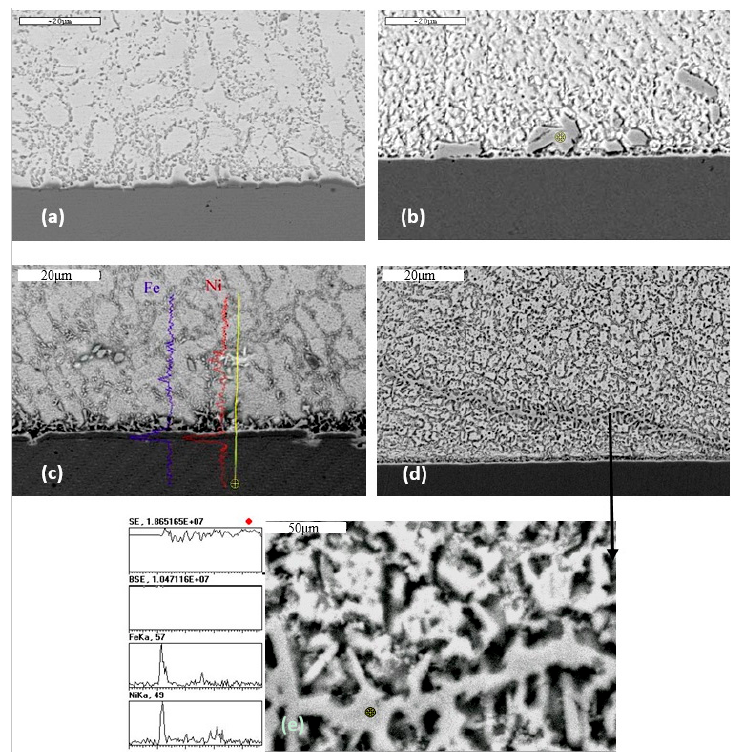
Figure 4. Interfacial IMCs of Sn-Ag-Cu/FeNi/Cu interface after reflow for ( a ) 90 s, ( b ) 150 s, ( c ) 210 s, ( d ) 270 s and ( e ) magnified image of ( d ). Table 1. Compositions of marked spots in Figure 4e and the possible phases. Elements Composition (at. %) Markers Possible Phases Fe Ni Cu Ag Sn